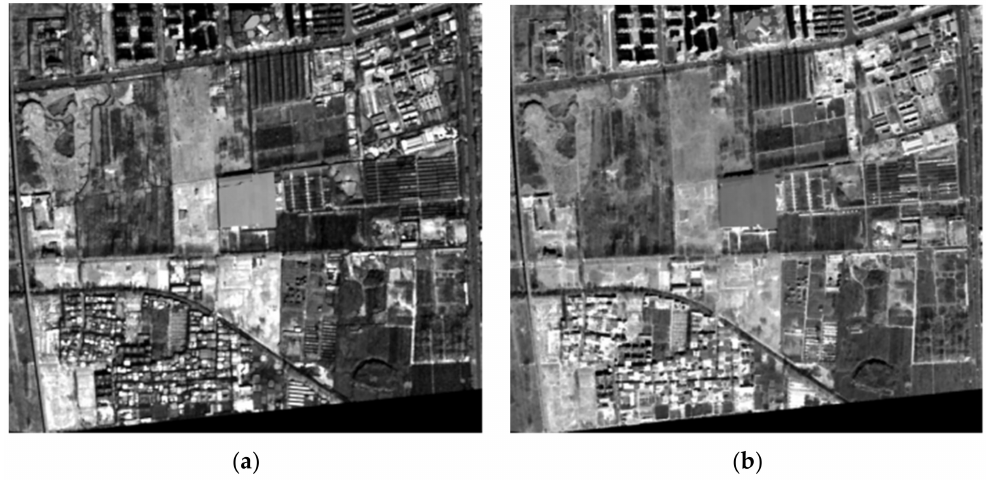
Figure 10. The results of opening ( a ) and closing ( b ) operations on study area A.